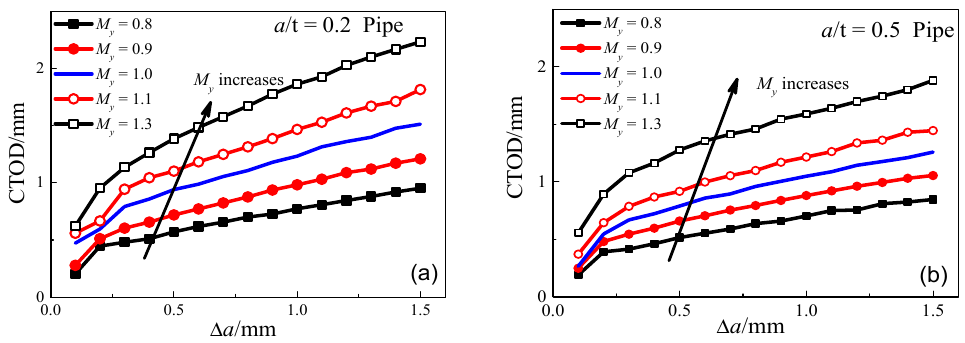
Figure 9. CTOD– ∆ a curves for pipes with different mismatch ratios, ( a ) a /t = 0.2; and, ( b ) a /t = 0.5.